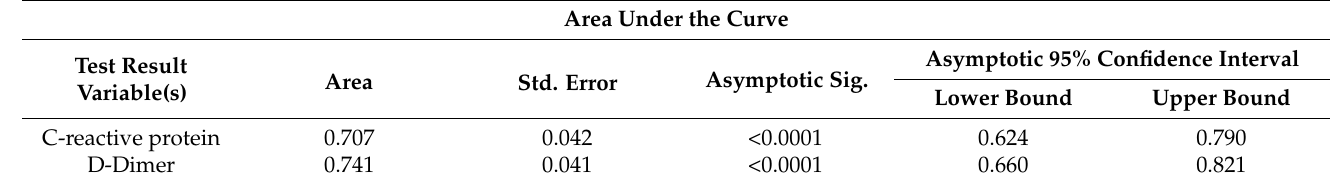
Table 7. AUC detailed analysis: the biomarkers’ capacity in predicting admission to ICU.